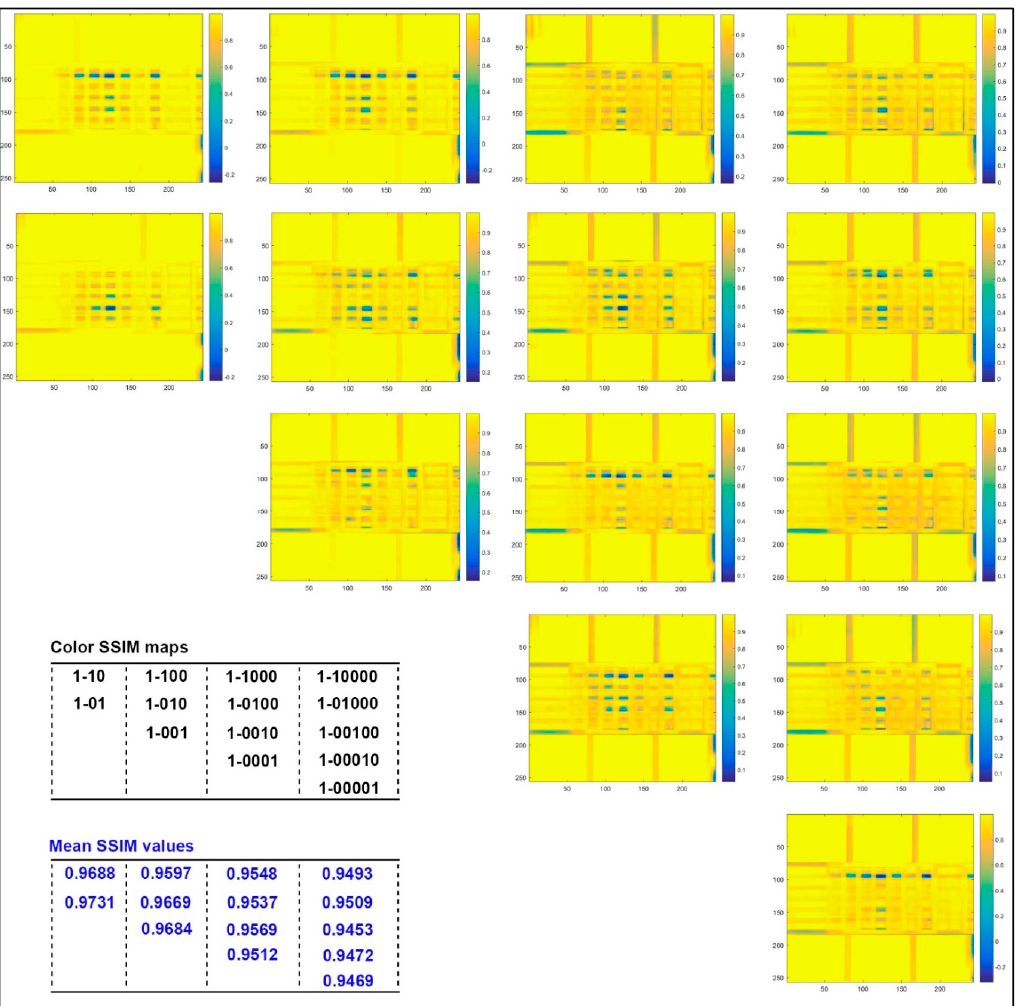
Figure 3. Color structural similarity (SSIM) maps and mean structural similarity (MSSIM) values for captured images of 3D color test charts compared to the sample with one single layer (sample 1).